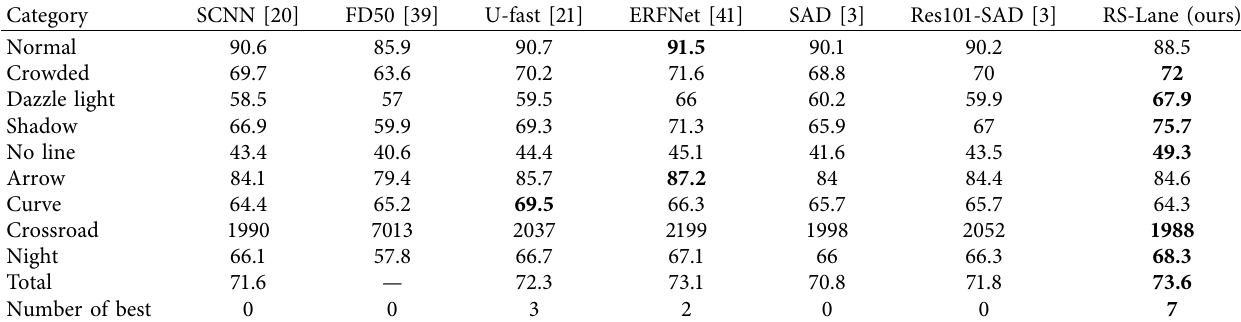
Table 4: Comparison on CULane testing set.